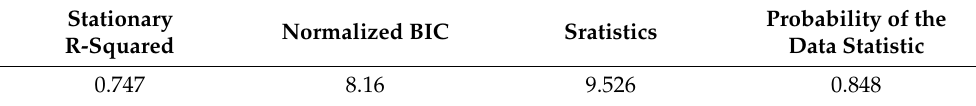
Table 5. Statistics of the Stationary R-squared and normalized BIC value for ARIMA(1,1,0)(0,1,1) model.